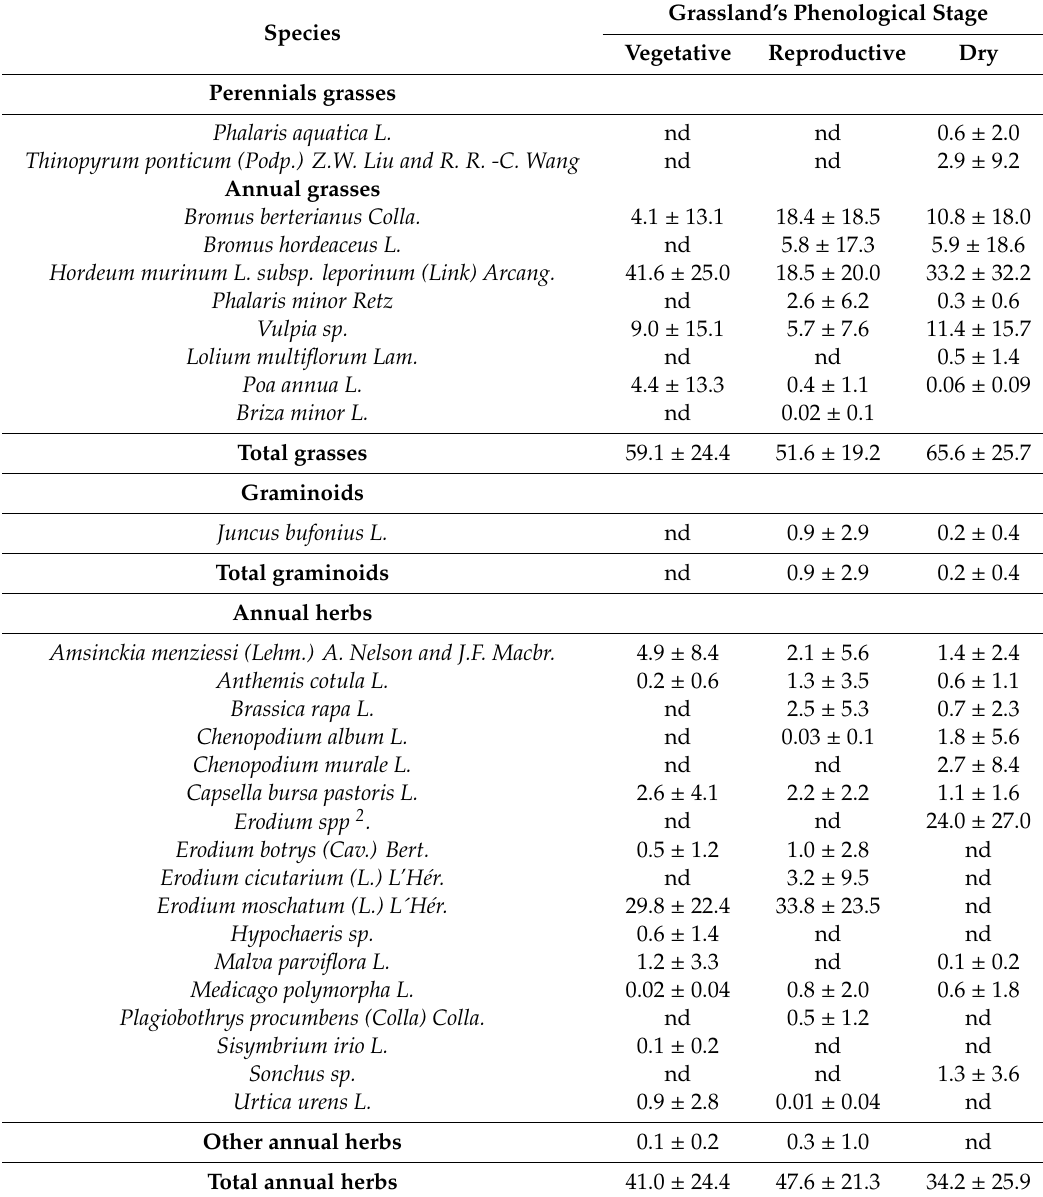
Table 2. Botanical composition of grassland in each phenological stage in the experimental grassland (%, mean 1 ± standard